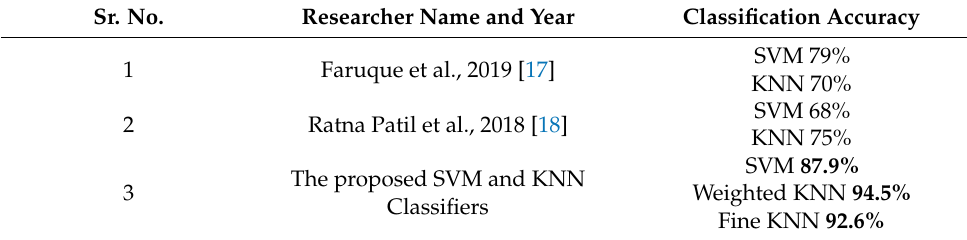
Table 6. Comparison of the accuracy of SVM and KNN classifiers with other